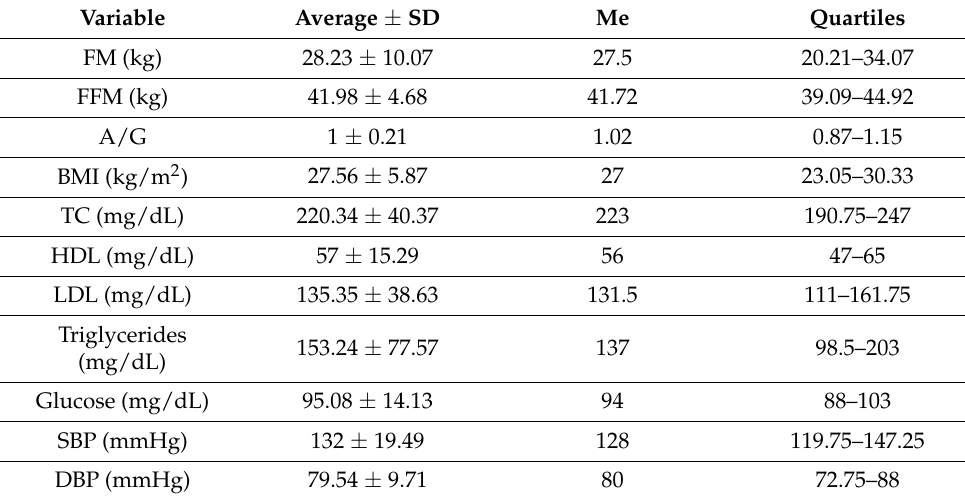
Table 2. Values of individual parameters in the study group.